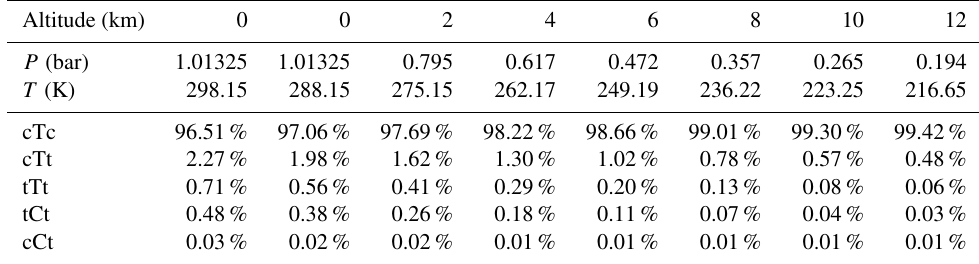
Table 3. Conformational population for OA conformers at different altitudes. Altitude (km)